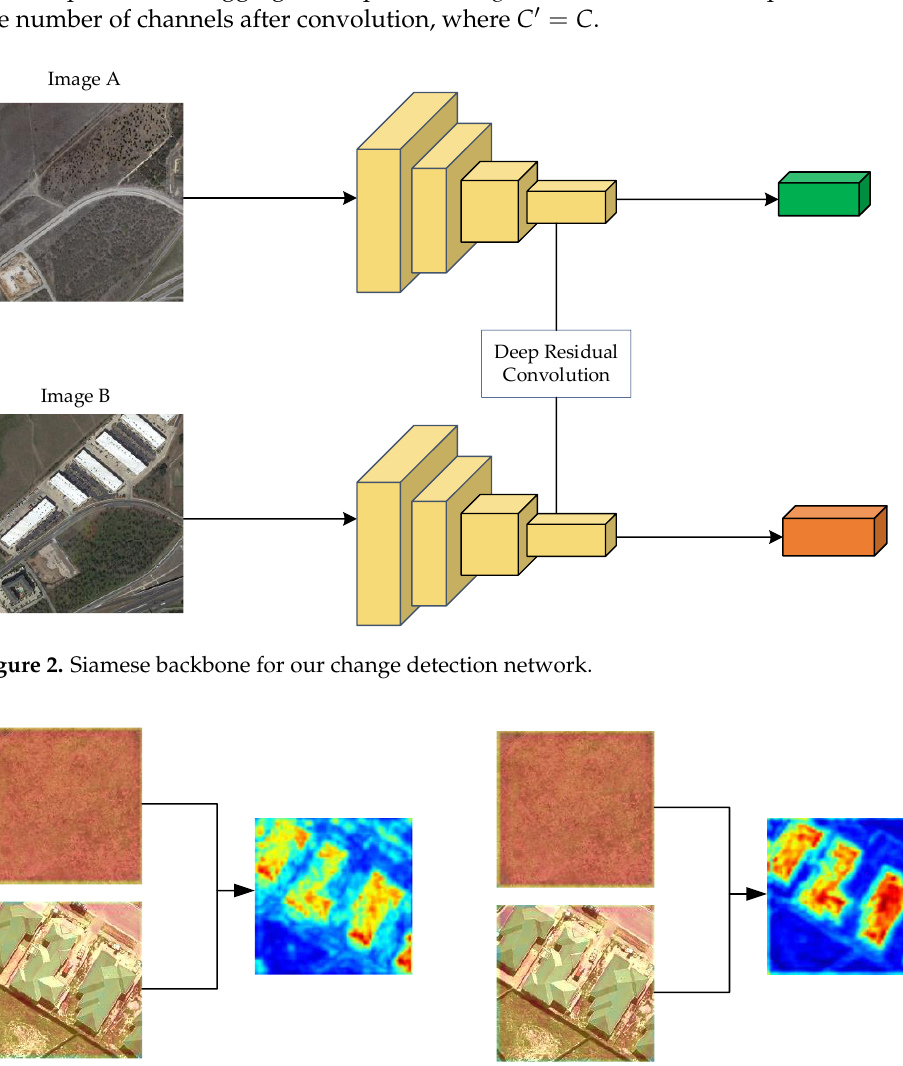
Figure 4. Classification head module. 2.1.4. Construction of Extra Predictions Although the ASPP3d difference feature extraction module proposed in this paper can simply aggregate the bitemporal feature relations, it fails to consider the multiscale resolution relations of multilevel feature maps. Therefore, in this paper, the Unet [40] structure, which consists of a symmetric encoder – decoder network with skip connections to enhance detail retention, is adopted to build an extra classification. The overall process is shown in Figure 5. Here, signal “ C ” represents the cascading and convolution of the